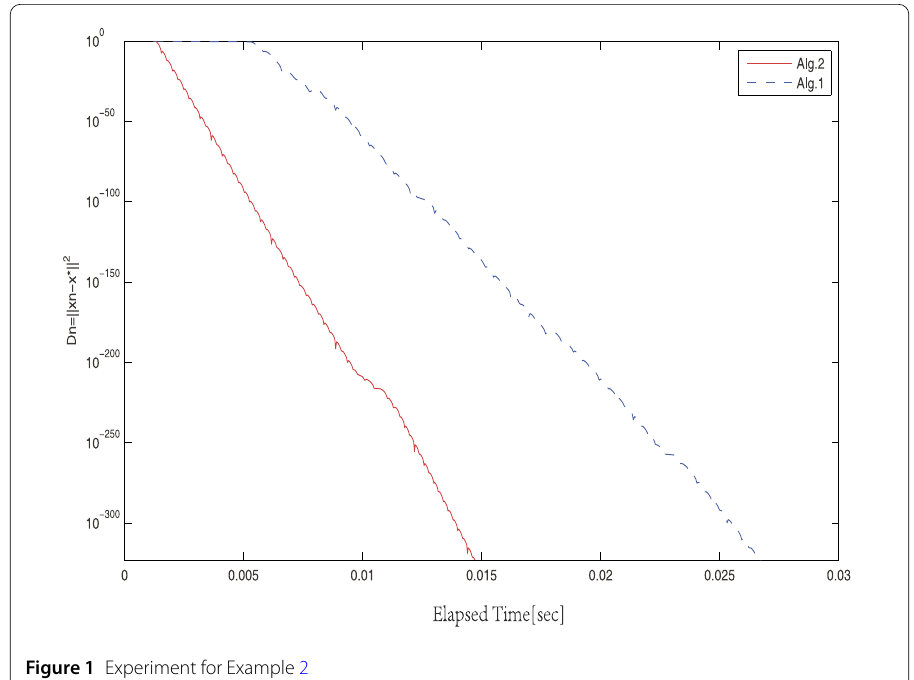
Figure 1 Experiment for Example